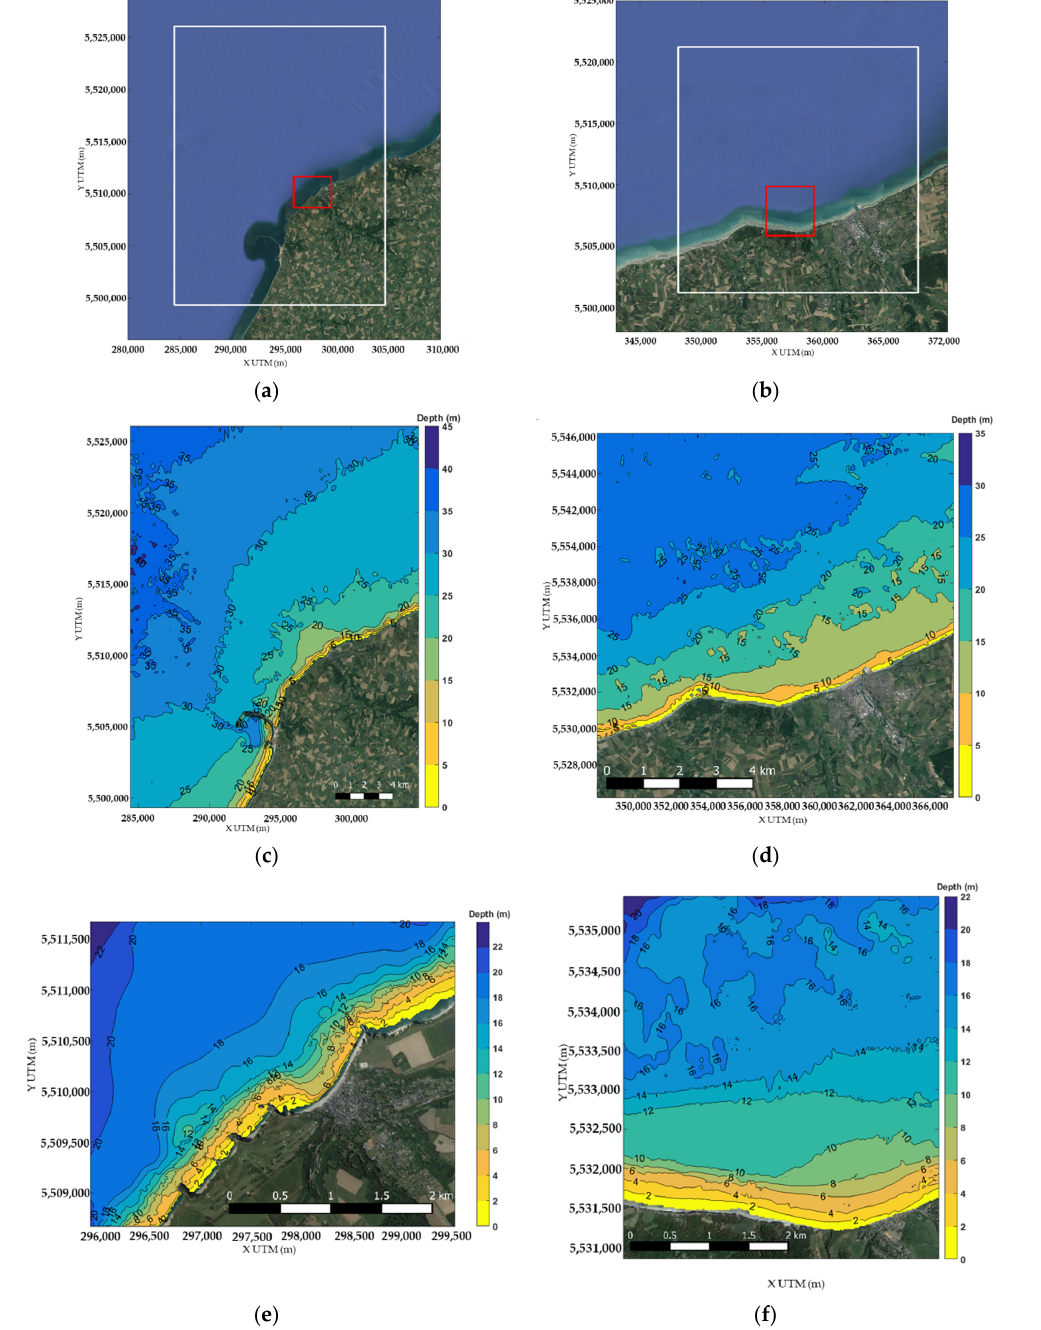
Figure 3. Coarse and nested grids, in white and red colors, respectively, for ( a ) Etretat and ( b ) Hautot- sur-Mer. DEMs of coarse grids in ( c ) Etretat and ( d ) Hautot-sur-Mer, and DEMs of nested grids in ( e ) Etretat and ( f ) Hautot-sur-Mer. Bathymetry data obtained from a merged DEM of EMODnet dataset and LiDAR campaign datasets. Satellite images from Google Earth. Model performances are assessed using standard statistical parameters, as in Stopa et al. [41], including the Root Mean Square Error (RMSE) (Equation (1)), the Pearson’s correlation coefficient (R) (Equation (2)), and the scatter index (SI) (Equation